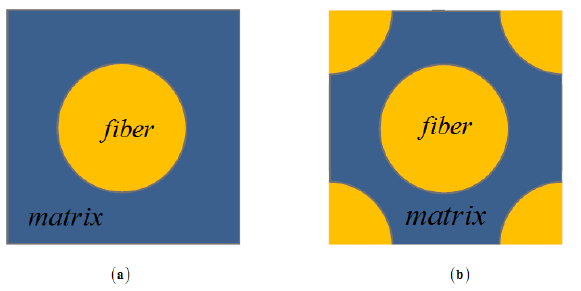
Figure 6: Unit cells with regular (a) square and (b) hexagonal fiber patterns